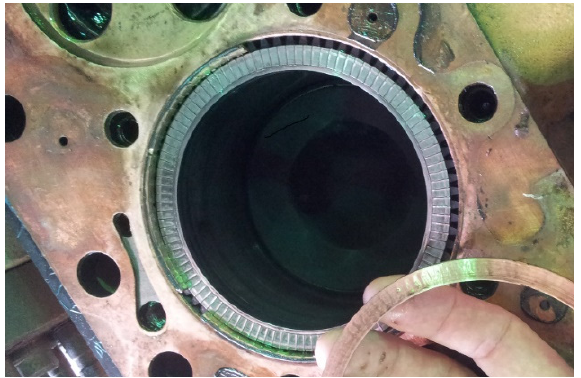
Figure 5. Details of the rotating liner face seal features. The copper head gasket only needs to seal oil and coolant. This picture is shown again in the Appendix A with a higher resolution.